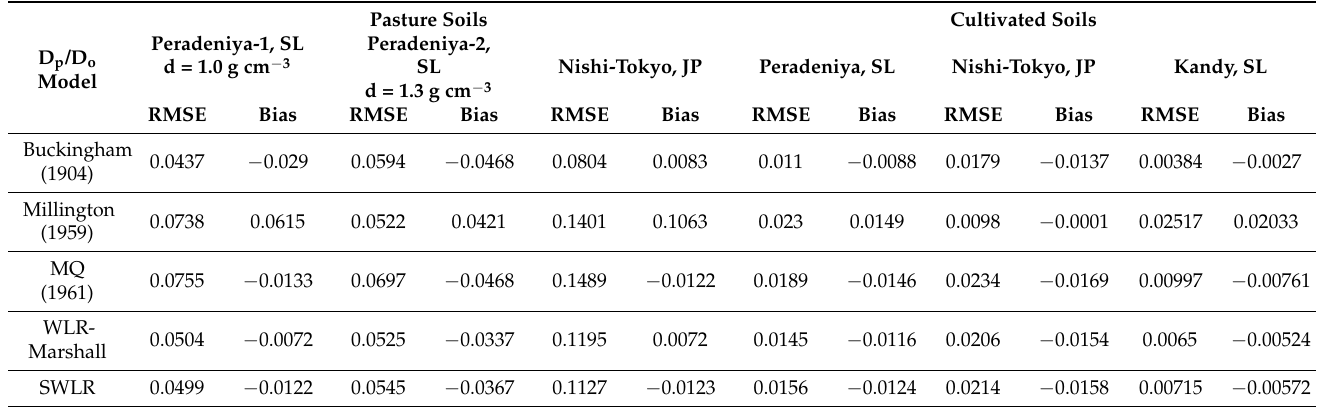
Table 4. Statistical analysis on model performance using RMSE (Equation (5)) and Bias (Equation (6)) for repacked